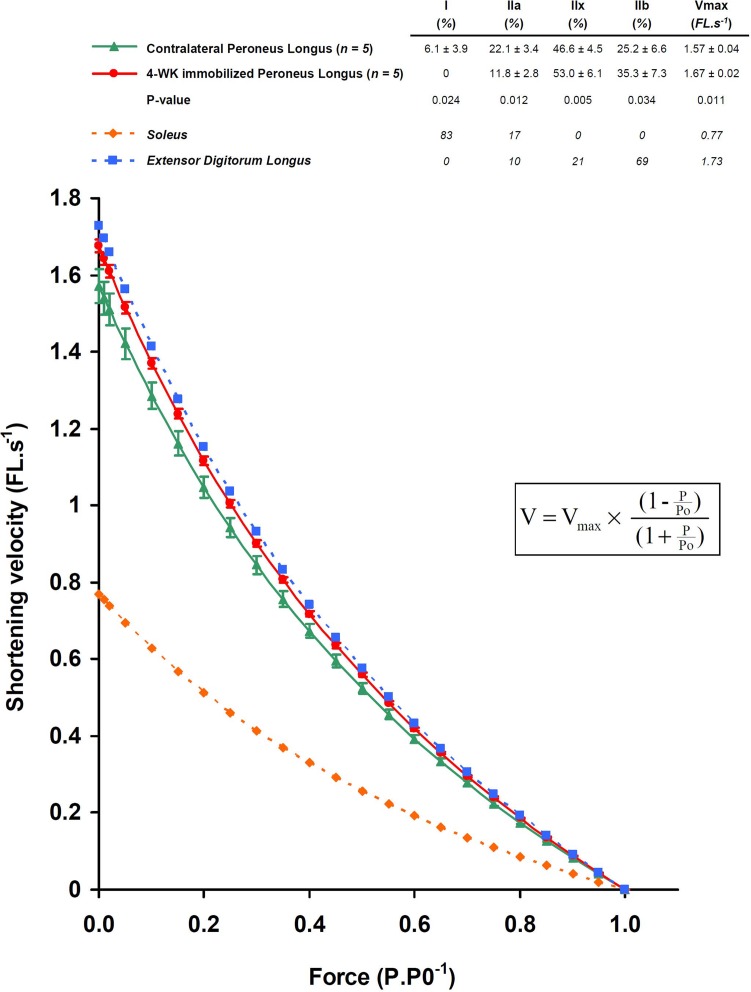
Prediction of the effects of immobilization on the force-velocity relationship.Whole muscle MHC isoform distribution in 4-wk immobilized and contralateral PL was determined from single-fibre analysis (pure and hybrid fibres), and compared to typical slow and fast muscles (Soleus and Extensor Digitorum Longus, respectively). Force-velocity curves were generated according to the Hill-type mathematical model (inset), by using the proportion of each MHC isoform in whole muscle. Data are expressed as mean ± SD. V, shortening velocity; Vmax, maximal shortening velocity; FL, fibre length; P, isotonic tension; Po, maximal isometric tension.